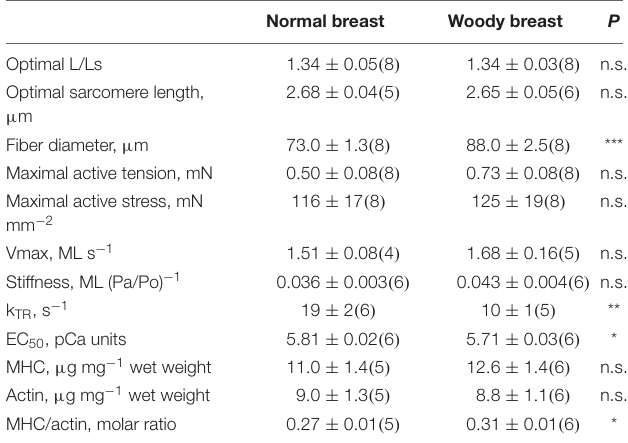
TABLE 1 | Mechanical data and contractile protein